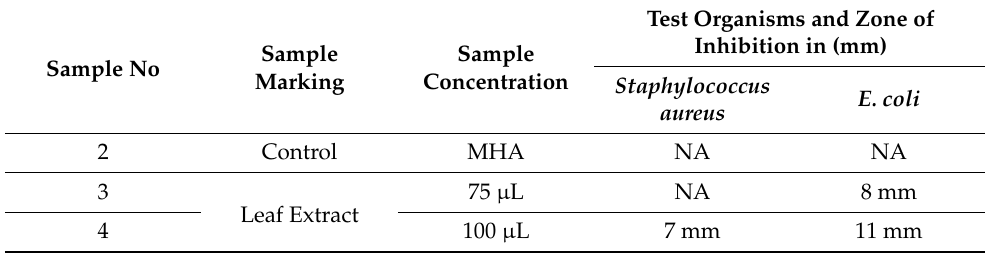
Figure 6. UV-Visible Spectrum of ZnO Nps.